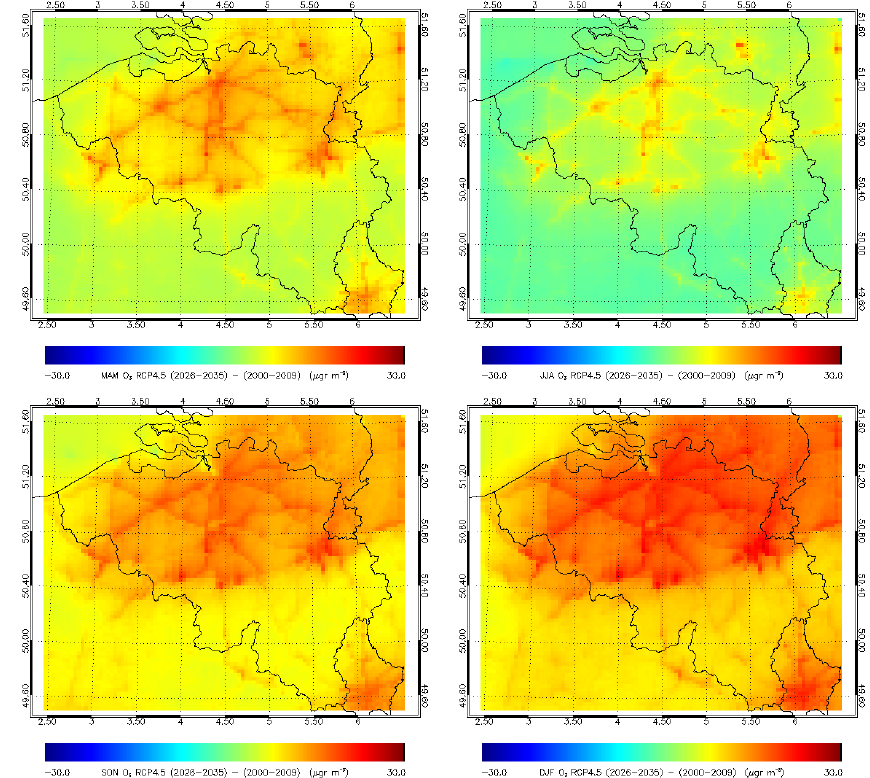
Figure 4. Mean difference maps between the near future (2026–2035) and the present day (2000–2009) for the RCP4.5 scenario per season.